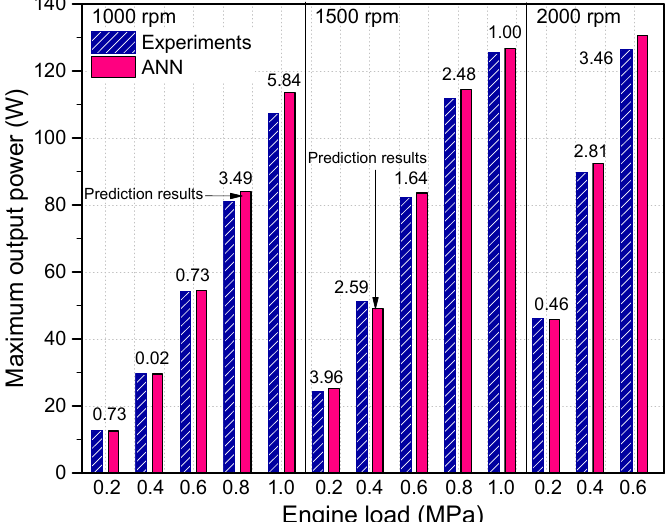
Figure 5. Comparison between the maximum output power obtained by experiments and that obtained by ANN training/prediction. The number above each bar graph indicates the percentage difference between the experimental and ANN results.